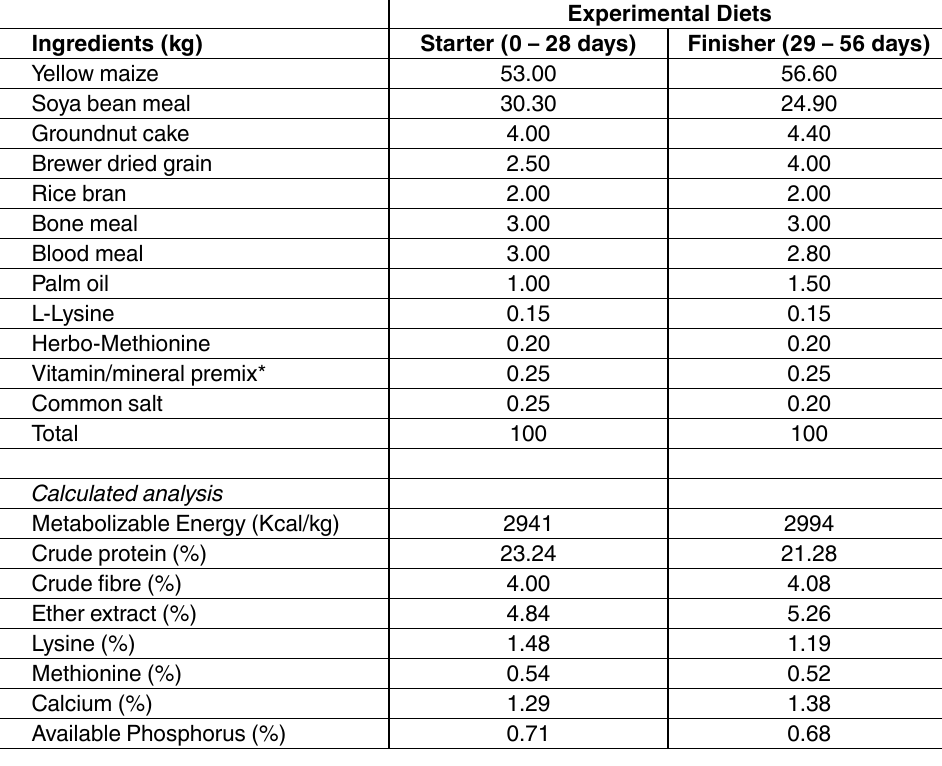
Table 1. Gross composition of the experimental